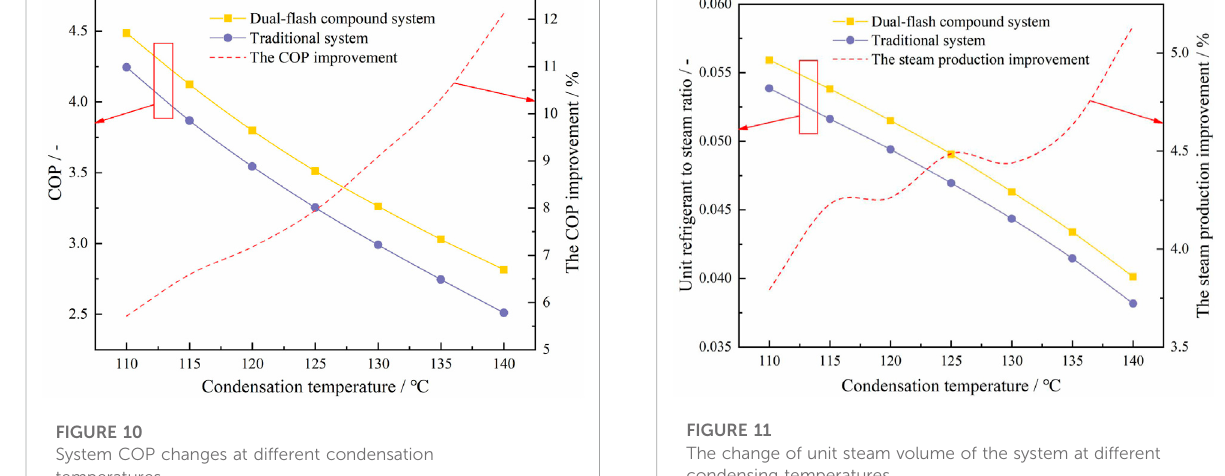
FIGURE 10 System COP changes at different condensation temperatures.